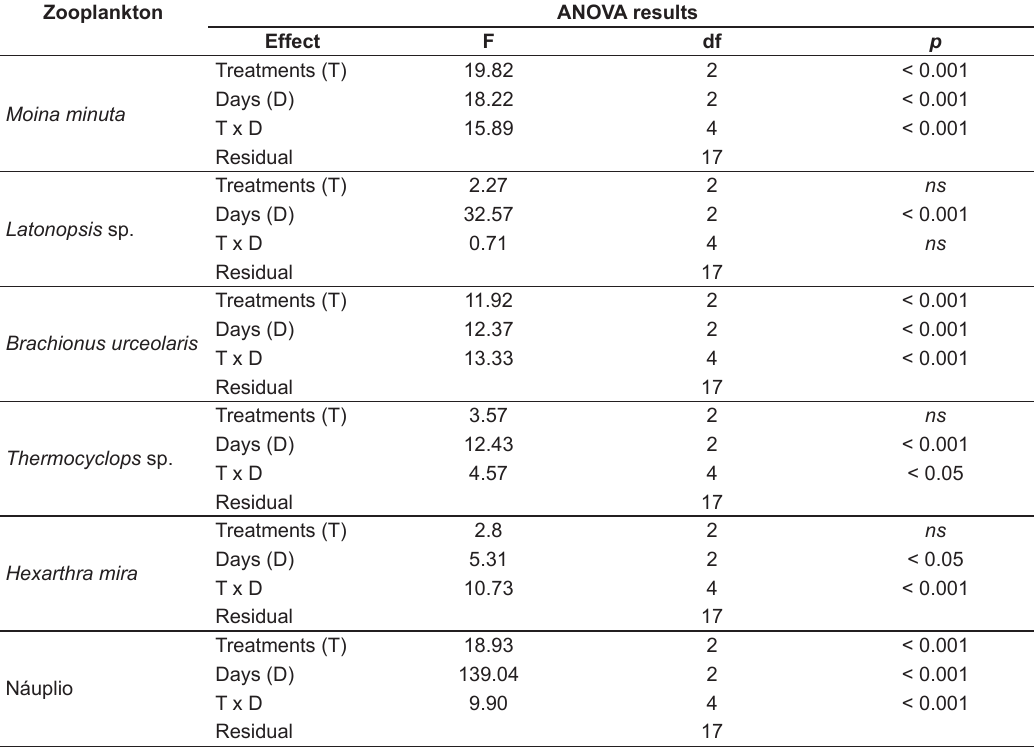
Table 2. Results of one-way ANOVAs testing the effects of treatments (mesotrophic, eutrophic and hypereutrophic), experiment days (days 1, 7 and 14) and their interaction term on the density of zooplankton. Zooplankton